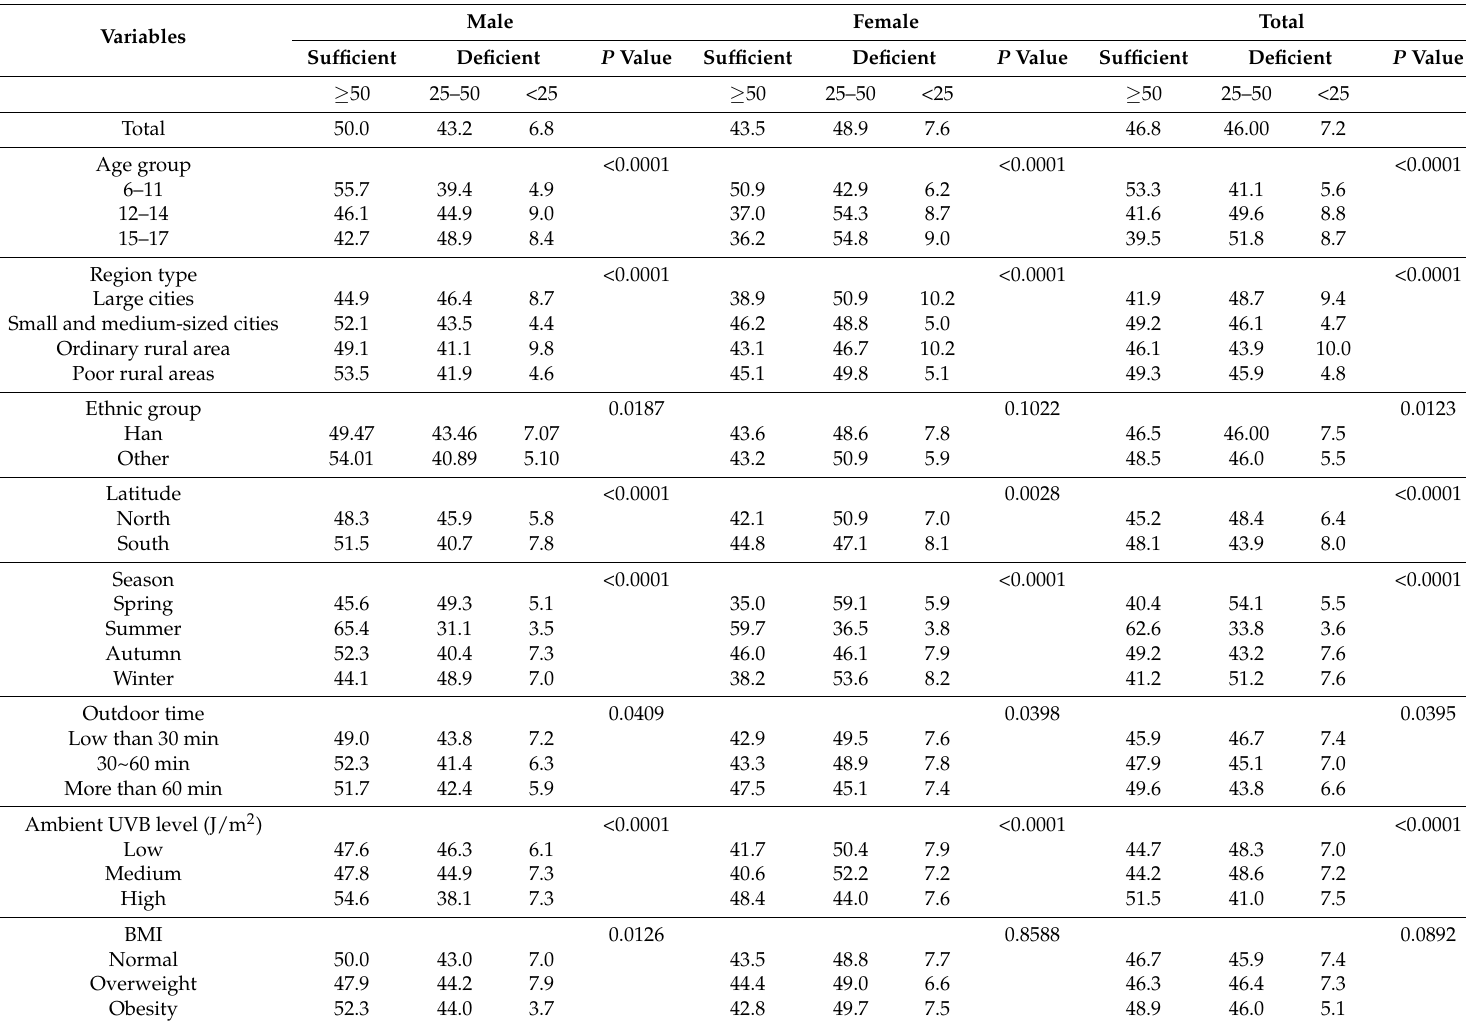
Table 2. Prevalence of vitamin D deficiency oinChinese children and adolescents in the Chinese nutrition and health survey 2010–2012